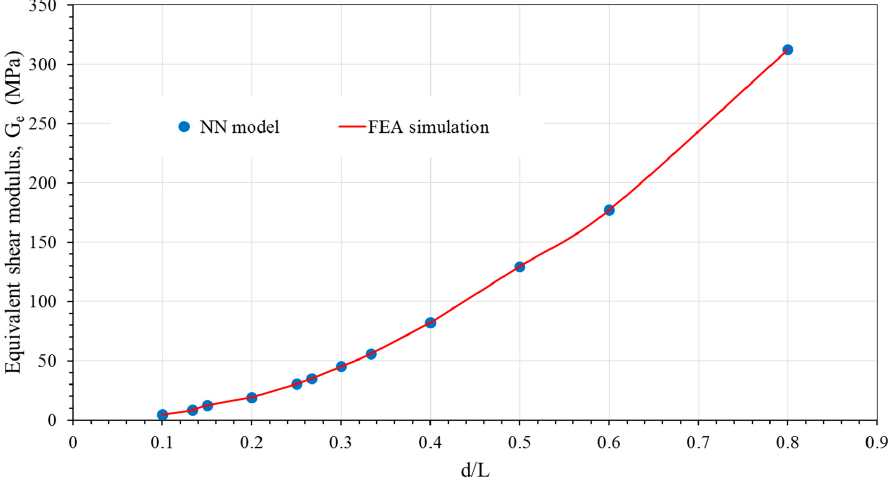
Figure 8. Comparison of equivalent shear moduli from FEA simulation and NN model for BCC pattern.